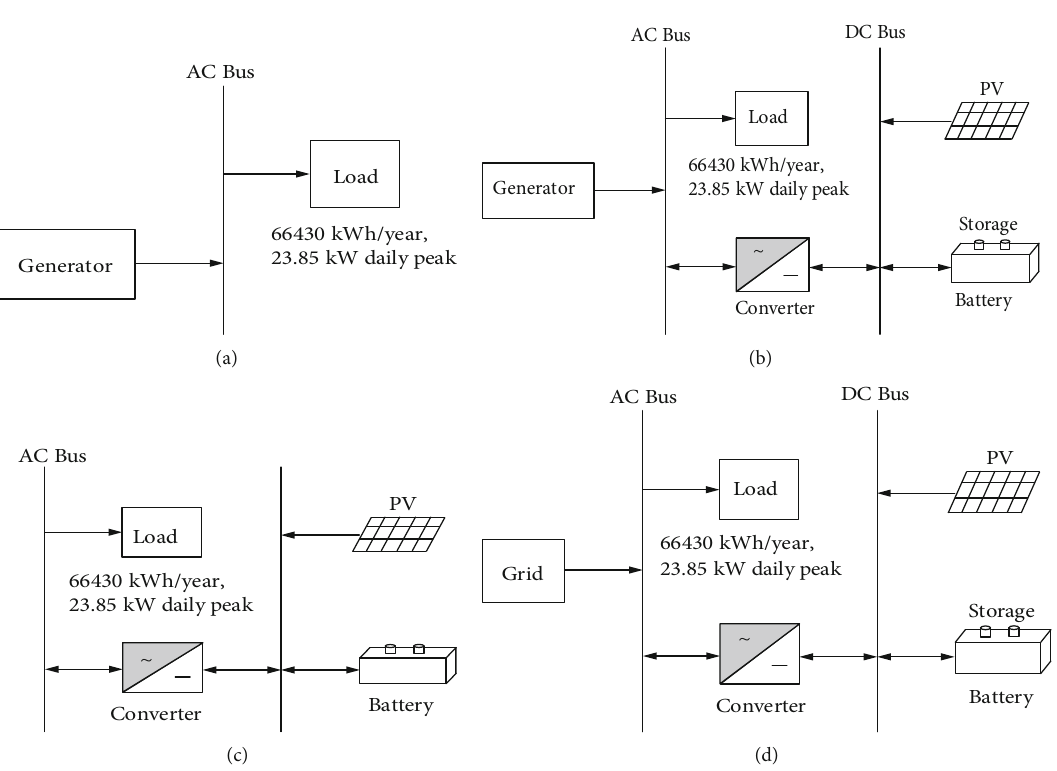
Figure 4: Various con fi gurations of energy technologies: (a) diesel technology, (b) diesel + PV technology, (c) PV + battery storage technology, and (d) PV + battery storage + grid